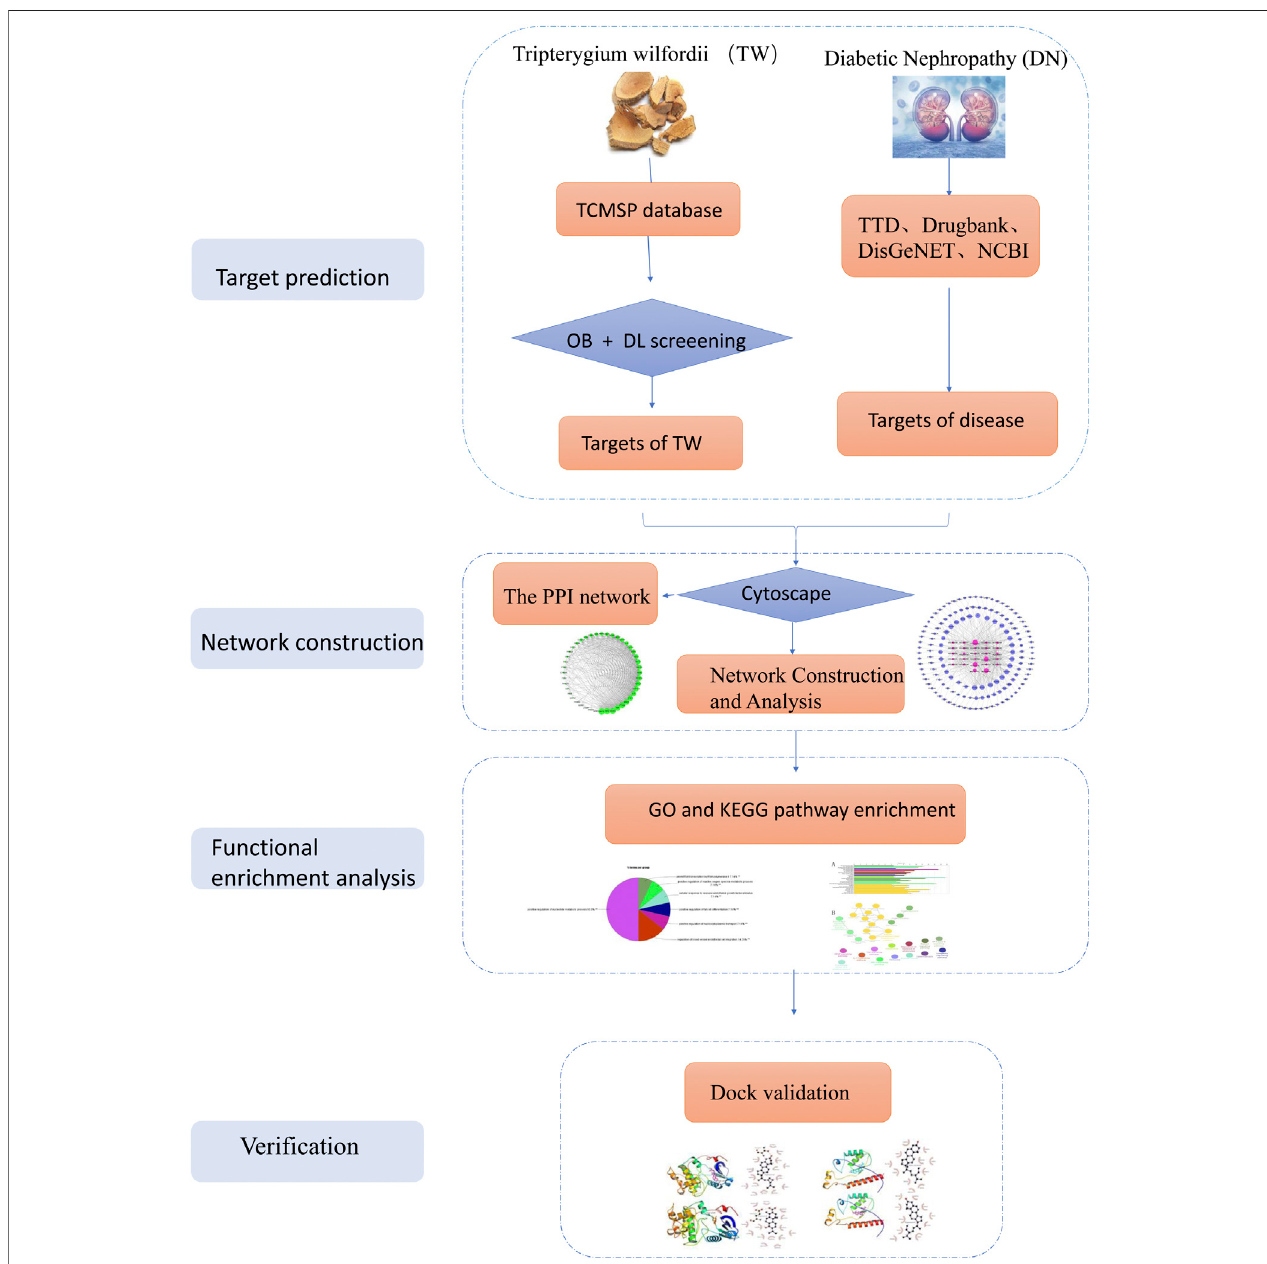
FIGURE 1 | The work fl ow of the analysis for this